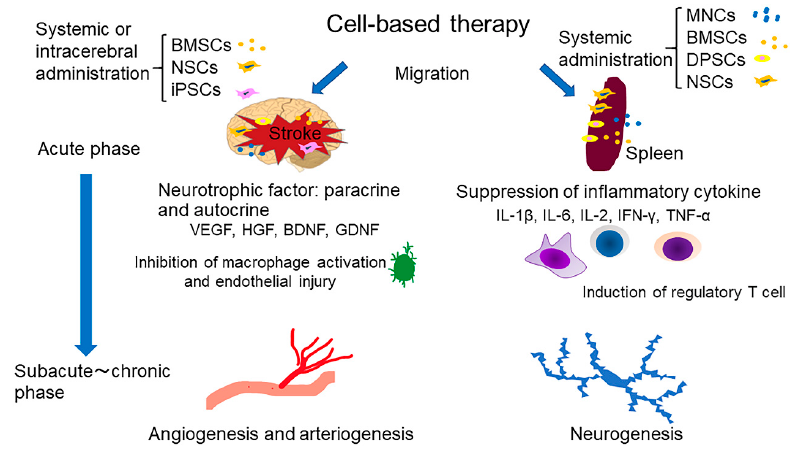
Figure 1. Overview of proposed mechanisms of cell-based stroke therapies. Engrafted therapeutic cells exert neuro- and vaso-protective effects through secretion of various growth factors and systemic inflammation modulation. MNCs, marrow mononuclear cells, BMSCs, bone marrow mesenchymal stem cells; DPSCs, dental pulp stem cells; NSCs, neural stem cells; iPSCs, induced pluripotent stem cells; VEGF, vascular endothelial growth factor; HGF, hepatocyte growth factor; BDNF, brain-derived neurotrophic factor; GDNF, glial cell-derived neurotrophic factor; IL-1 β , interleukin 1 beta; IL-6, interleukin 6; IL-2, interleukin 2; IFN- γ , interferon gamma; TNF- α , tumor necrosis factor